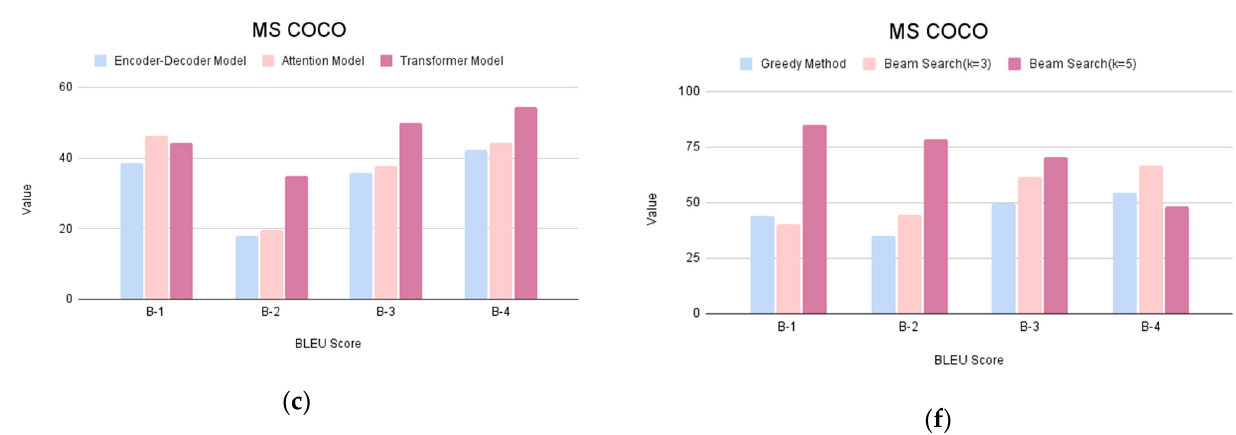
Figure 4. ( a – c ) : shows the BLEU scores of the attention model, encoder–decoder model, and transformer model in which the latter has the highest value of scores; ( d – f ) shows the BLEU scores of the transformer model using greedy search, beam search (k = 3), and beam search (k= 5) on Flickr 8k, Flickr 30k, MS COCO datasets.